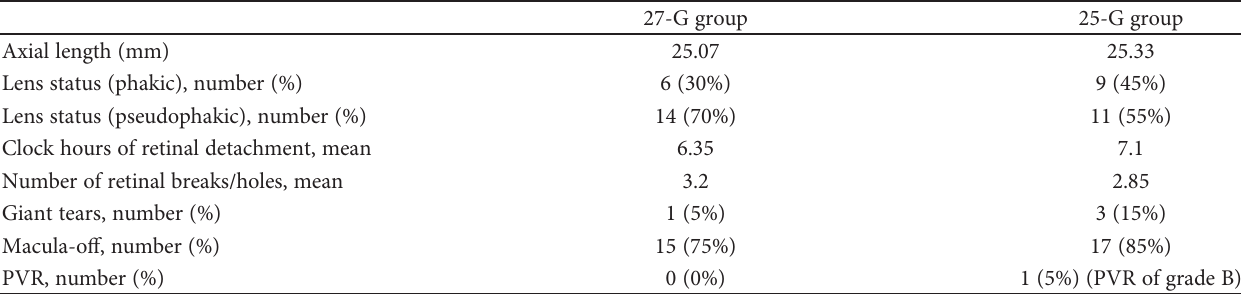
Table 1: Clinical data of patients.